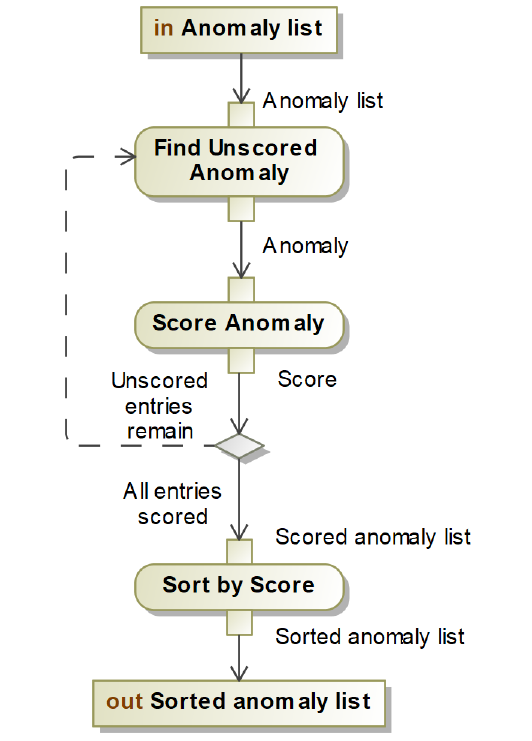
Figure 5. Preprocessing the anomaly